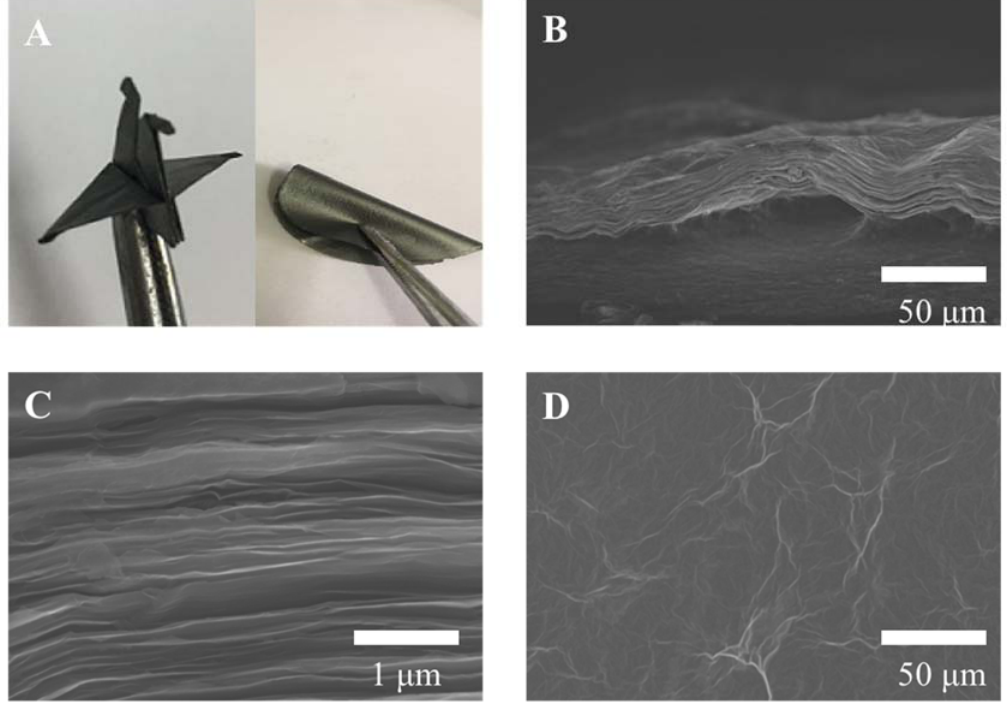
Figure 2. ( A ) Digital photo of rGOP. SEM images of rGOP, with ( B ) and ( C ) cross-section view and ( D ) top view.